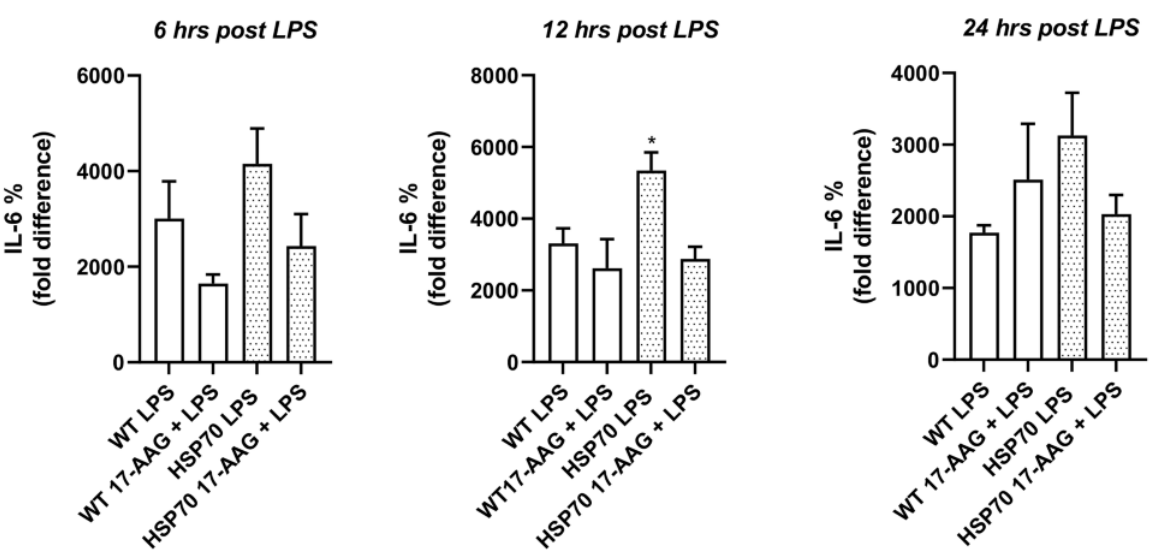
Figure 6. E ff ect of LPS upon HSP90 inhibition in primary macrophages of Hsp70+/+ and Hsp70-/- mice. 17-AAG (500 nM) was applied 2 hrs before LPS treatment. ELISA analysis of IL-6 at 6, 12 and 24 hrs post LPS. *, p < 0.05. Each graph shows a representantive experiment of at least three indepedent